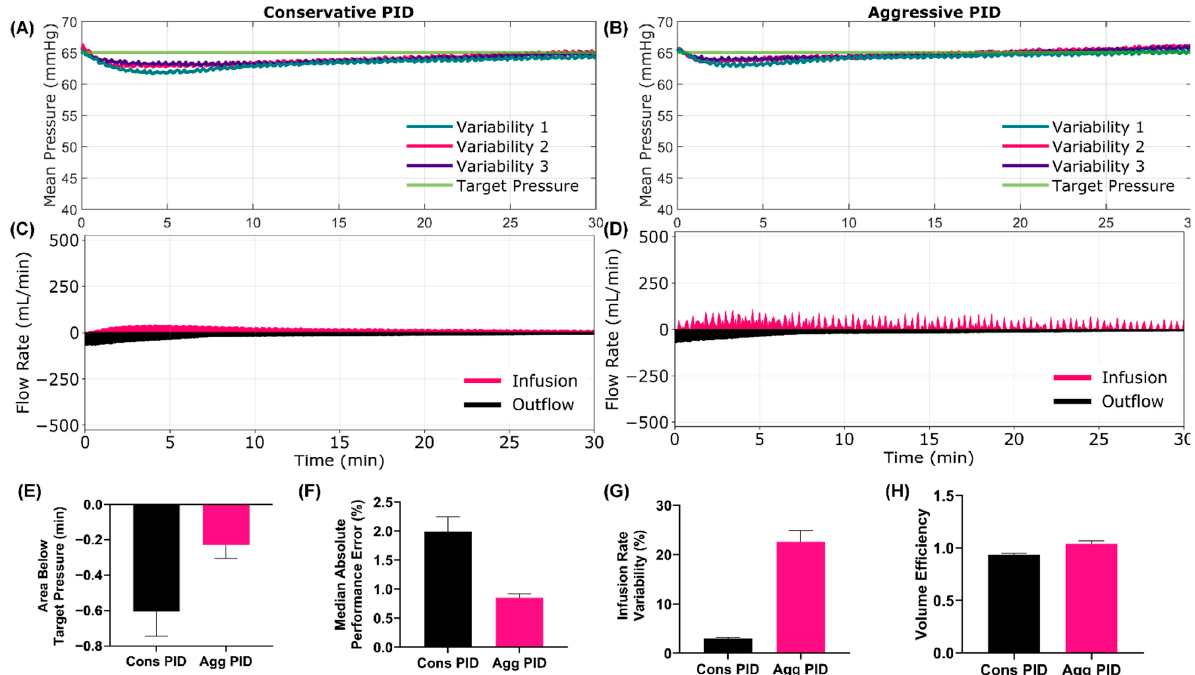
Figure 3. Scenario 3 Testing Results . Scenario 3 began at a stable 65 mmHg starting MAP with a slow active bleed that clotted over the 30-min testing scenario. WB infusate was used for this scenario. Results for the conservative ( A , C ) and aggressive ( B , D ) tuned PID are shown for ( A , B ) MAP and ( C , D ) infusion and outflow rates versus time, as the controller tried to maintain a target MAP of 65 mmHg. For MAP plots, each of three subject variability runs are plotted individually, while a single representative run is shown for the inflow/outflow plots. Average controller performance metrics for ( E ) area below target pressure, ( F ) MDAPE, ( G ) infusion rate variability and ( H ) volume efficiency are shown for both controller tunings for this scenario. Error bars denote standard deviation ( n =